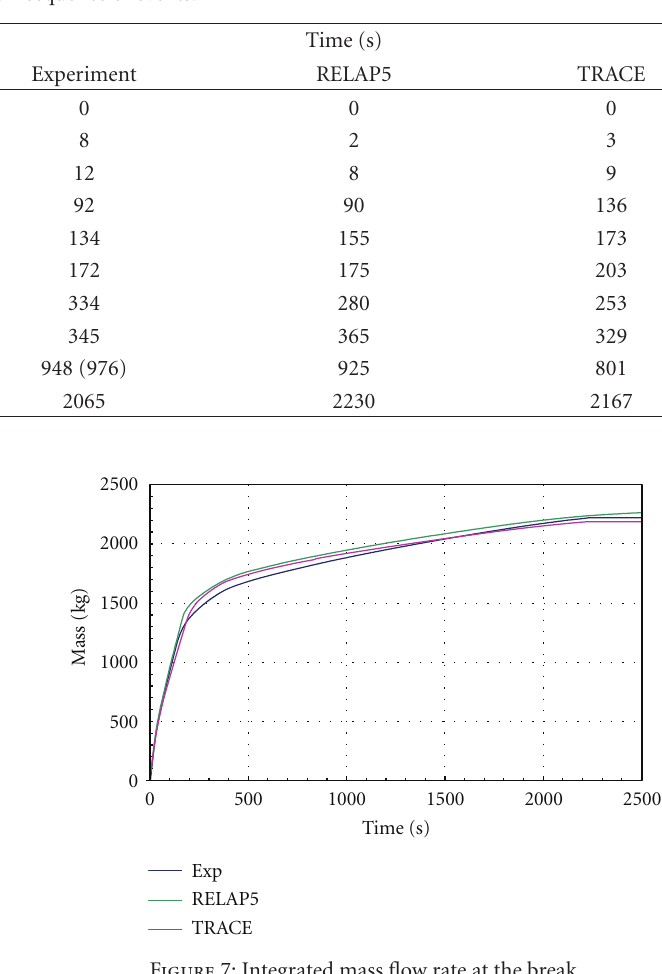
Figure 7: Integrated mass flow rate at the